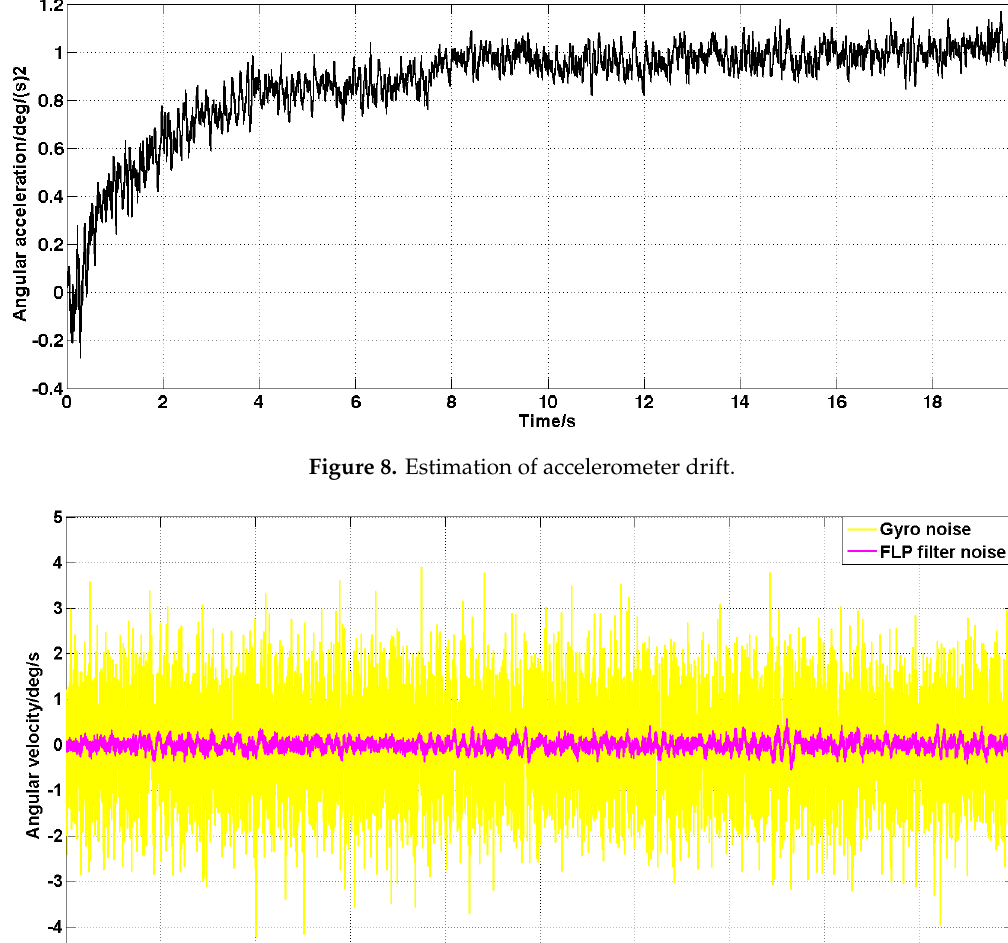
Figure 7. The angular acceleration signal filtered by the Kalman algorithm.